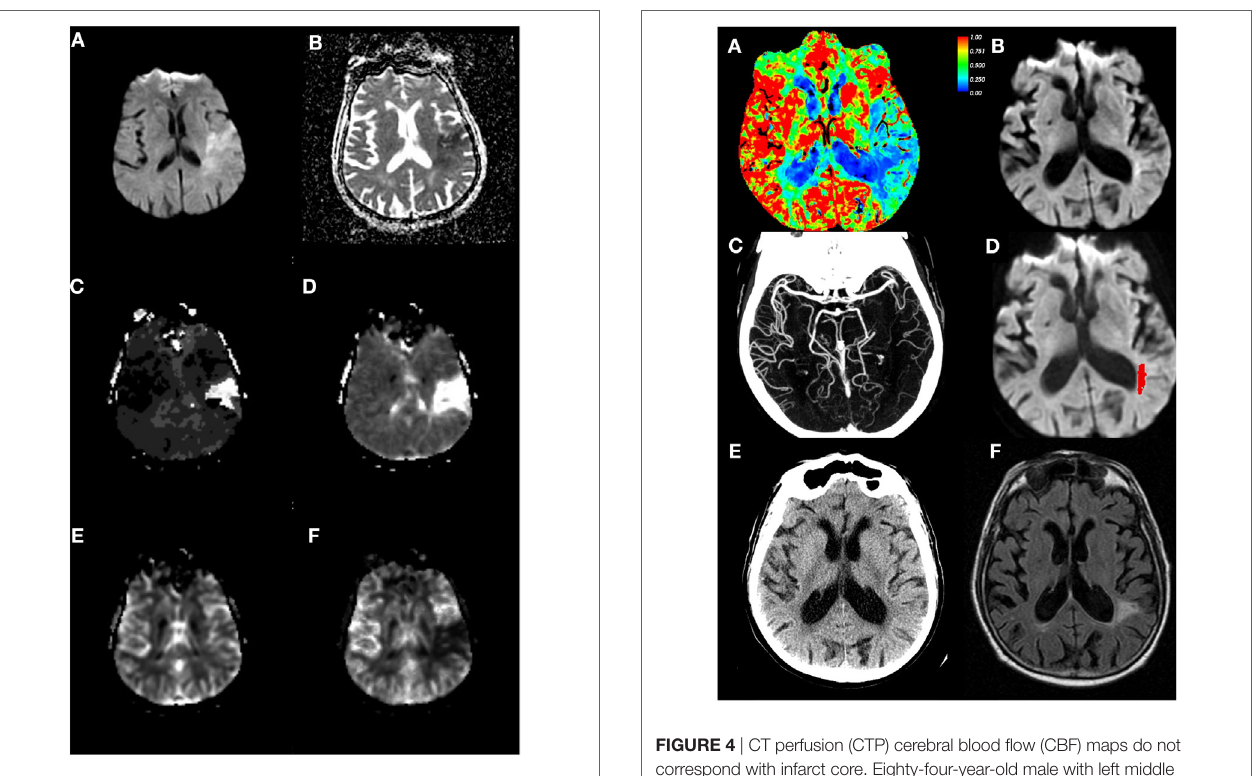
FigURe 3 | Perfusion–Diffusion mismatch to identify salvageable tissue. (A) Diffusion-weighted imaging and (B) apparent diffusion coefficient sequences showing mismatch of ischemic core to a greater volume of hypoperfused tissue on (C) T max and (D) mean transit time sequences. (e) Cerebral blood volume and (F) cerebral blood flow sequences. Data analysis for figure was created under approval of local ethics